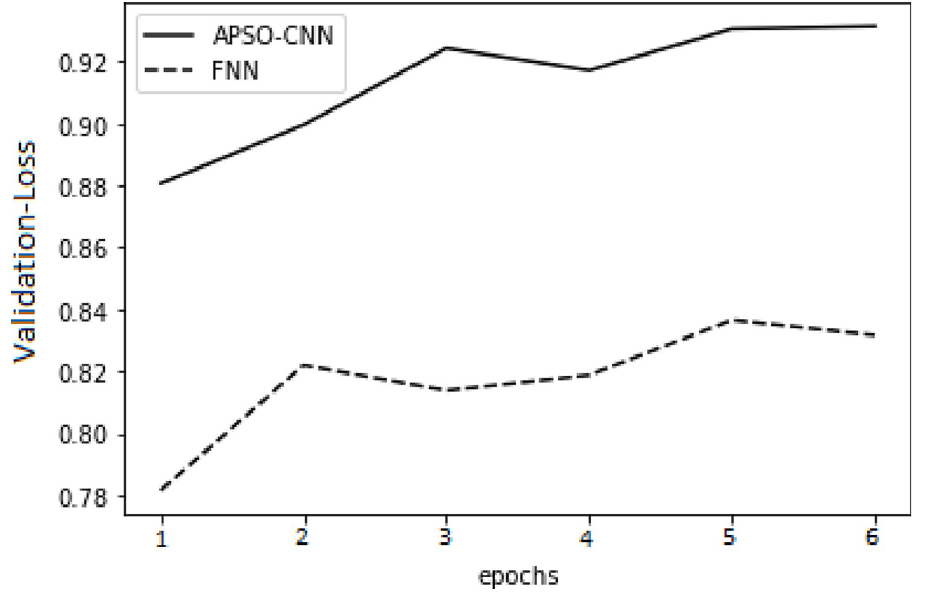
Fig 13. APSO–CNN and FNN algorithms’ accuracy validation